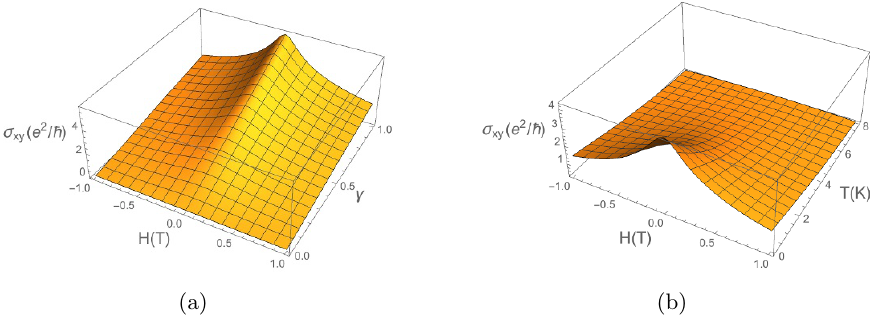
Figure 3 . Transverse conductivity (cid:27) xy (a) as a function of Magnetic doping and magnetic (cid:12)eld at T = 2 K and (b) as a function of Temperature and magnetic (cid:12)eld at q (cid:31) (cid:13) = 0 : 7.